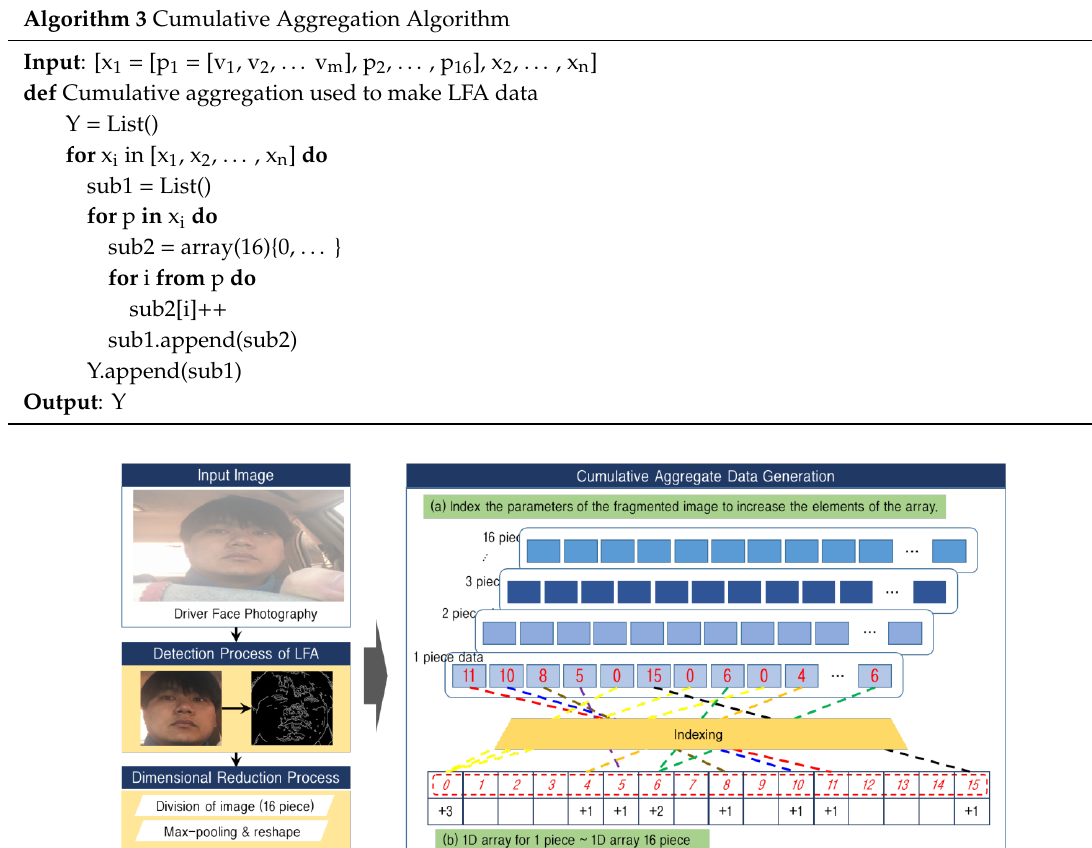
Figure 6. Process of cumulative aggregate data generation: ( a ) Index the parameters of the fragmented image to increase the elements of the array; ( b ) 1D array for 1 piece~1D array 16 piece.